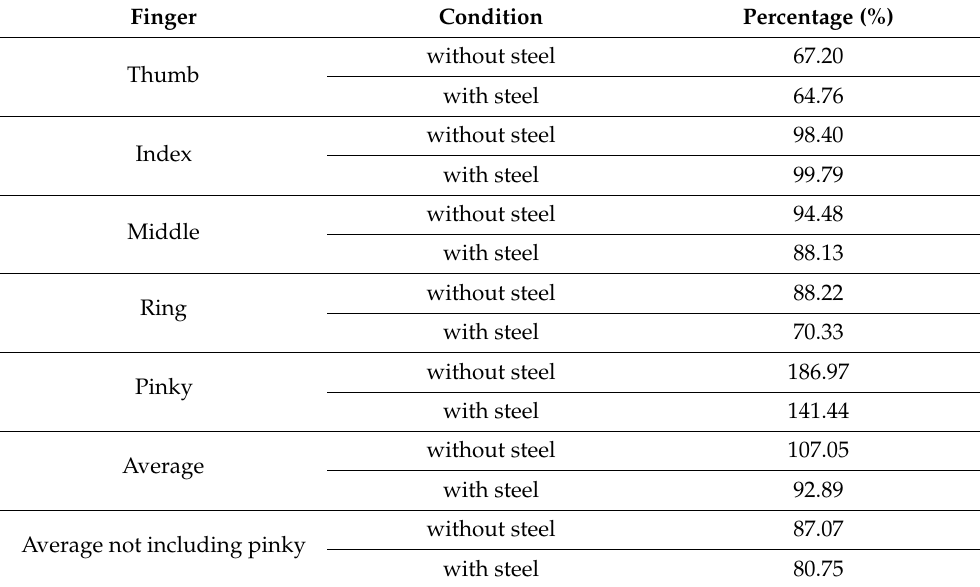
Table 5. Percentage of “no glove” condition ROM met by peak angles during pneumatic actuation Trials with and without steel